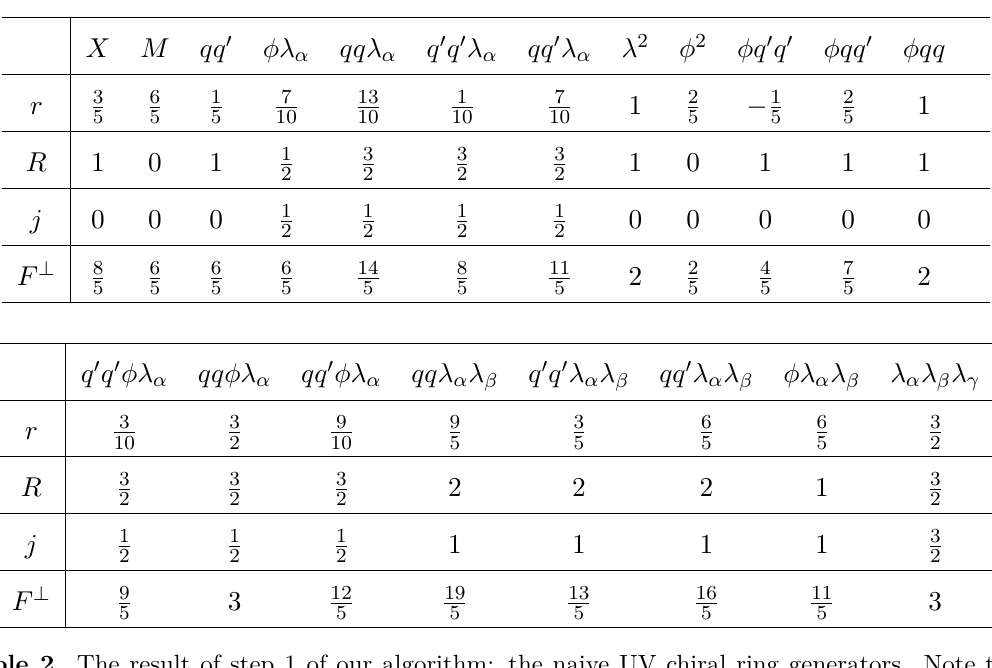
Table 2 . The result of step 1 of our algorithm: the naive UV chiral ring generators. Note that qq 0 := (cid:15) ij q i q 0 j . We use δ ab to write the remaining generators involving gauge non-singlets in the first line (e.g., qqλ := δ ab ( qq ) ) and (cid:15) abc to write the generators in the second line (e.g., a λ αb q 0 q 0 φλ α := (cid:15) abc ( q 0 q 0 ) a φ b λ αc ). Recall that F ⊥ := R + r is a flavor symmetry with respect to